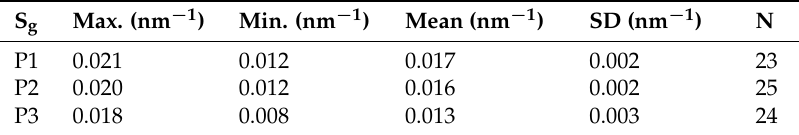
Table 3. CDOM absorption spectral slopes (S g ) at Stations P1, P2 and P3. “Max.”, “Min.”, and “SD” stand for maximum, minimum, and standard deviation, respectively, and “N” is the number of samples.